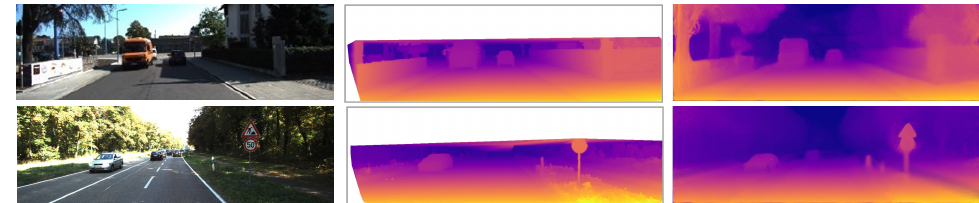
Figure 2. Examples of PDANet’s results on KITTI2015 [6]. From left to right: input images, ground truth disparity maps, and results of